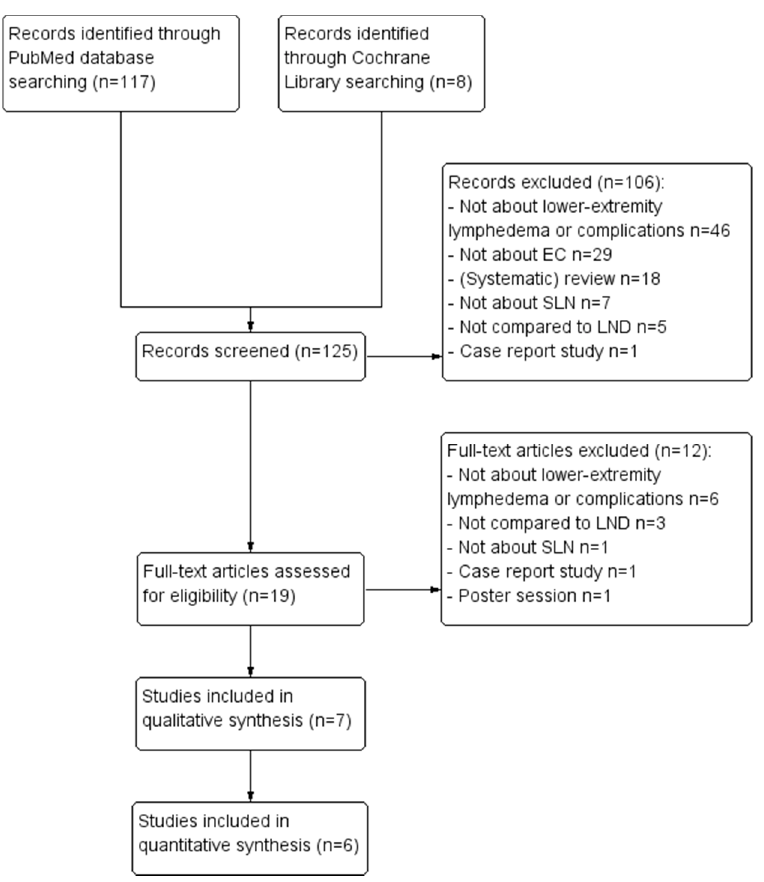
Figure 1. PRISMA flow chart of excluded articles. Abbreviations : LND lymph node dissection, SLN sentinel lymph node procedure, EC endometrial carcinoma.